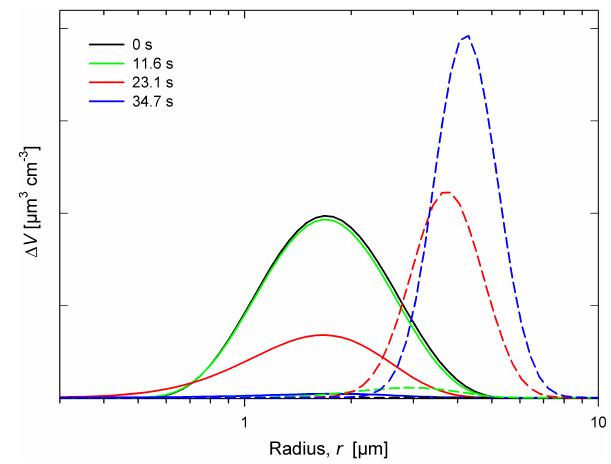
Fig. 6. Time evolution of volume distributions of supercooled water (solid lines) and ice (dashed lines) at 0, 11.6, 23.1, and 34.7s for a sample model run for medium droplets at 235.7K.